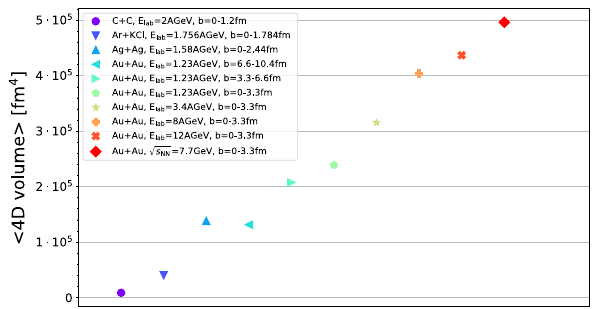
Fig. 18 Time integrated volumes of the various systems satisfying the conditions X < 0 . 3, Y < 0 . 3, ε > 1 MeV / fm